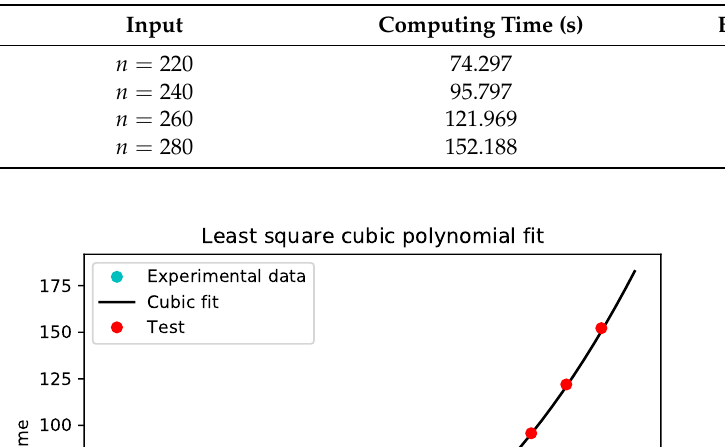
Table 2. Real computing time and expected time by the cubic fit in higher dimensions.